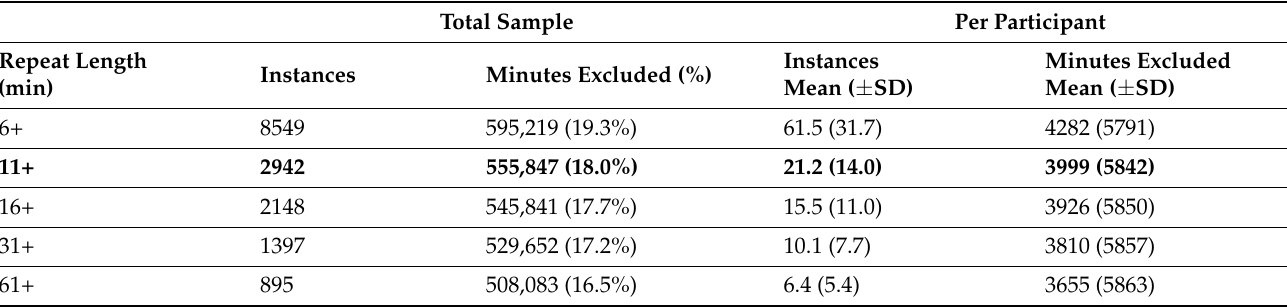
Table 4. Data exclusion based on aphysiologic signal—repeated heart rate values. Total Sample Per Participant